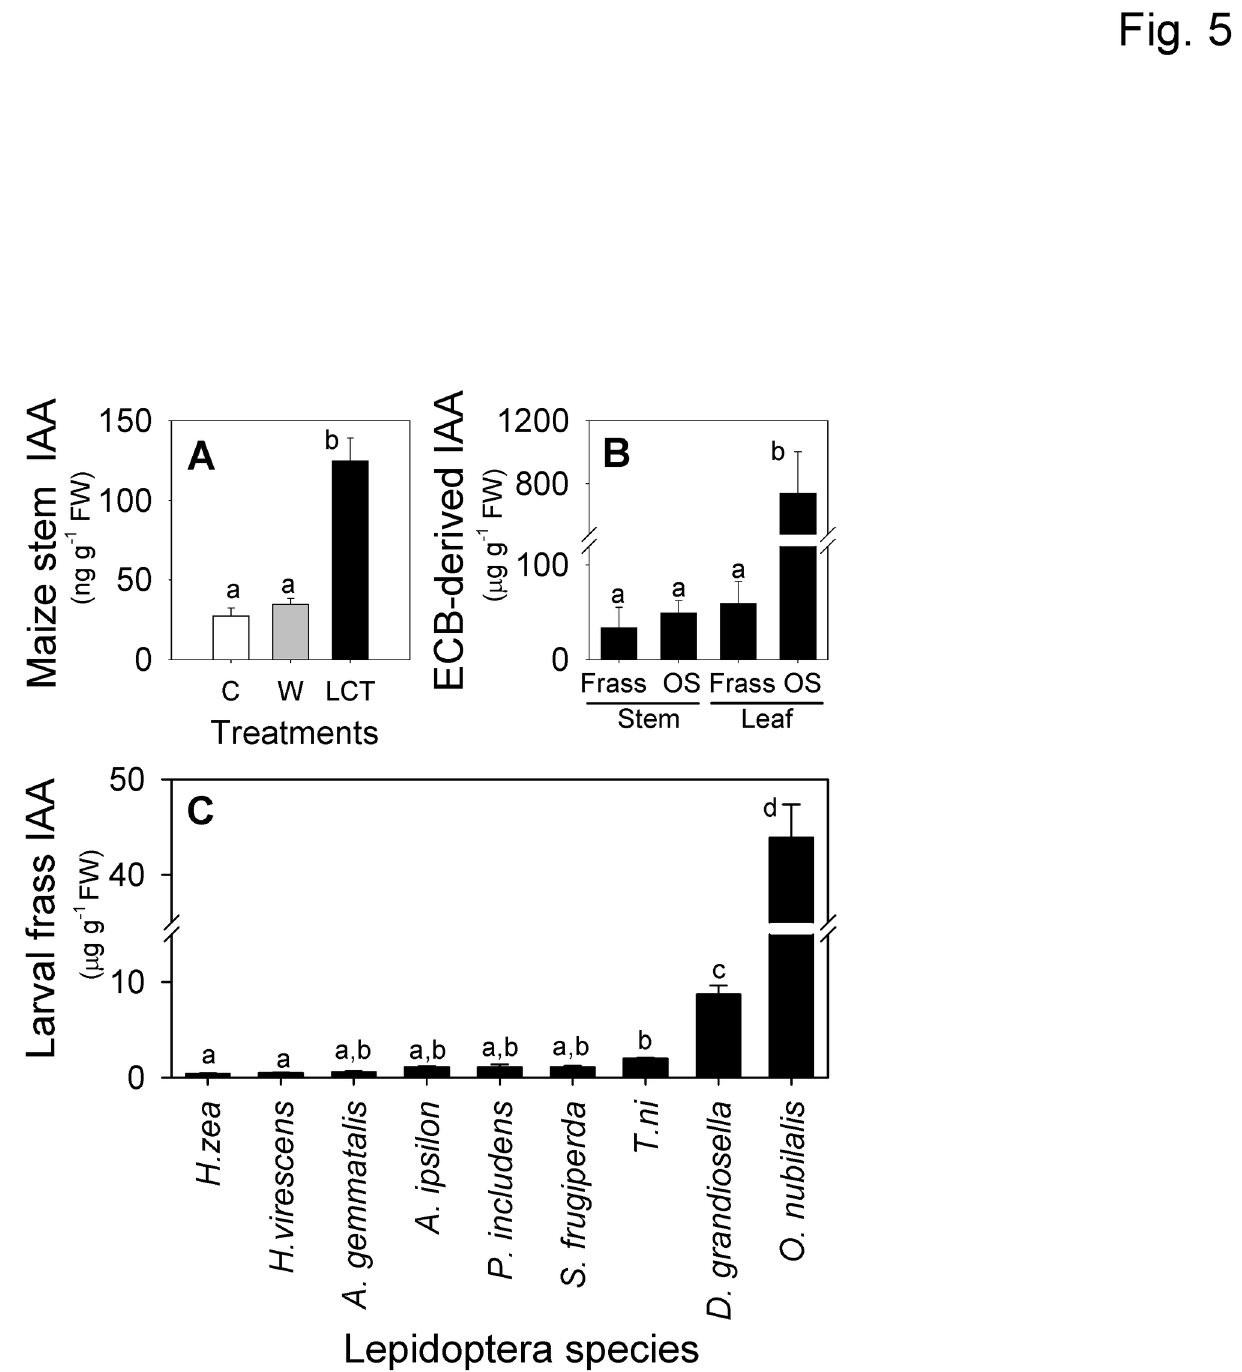
Figure 5. ECB oral secretions and frass contain unusually high levels of IAA. A , Average ( n = 3, +SEM) concentration of IAA in maize stem tissue collected from control (C), wounded (W), and ECB larvae-conditioned tissues (LCT) after 48 h. B , Average ( n = 4, +SEM) IAA levels in ECB OS or recently collected (1 h) frass following larval ingestion of maize leaf or stem tissue for 24 h. C , Average ( n = 3, ±SEM) IAA in frass of numerous Lepidopteran pest species ( Helicoverpa zeae , Heliothis virescens , Anticarsia gemmatalis , Agrotis ipsilon , Pseudoplusia includens , Spodoptera frugiperda , Trichoplusia ni , Diatraea grandiosella and Ostrinia nubilalis : ECB) reared on artificial diet. Different letters (a–d) represent significant differences (all ANOVAs P < 0.01; Tukey test corrections for multiple comparisons, P < 0.05).